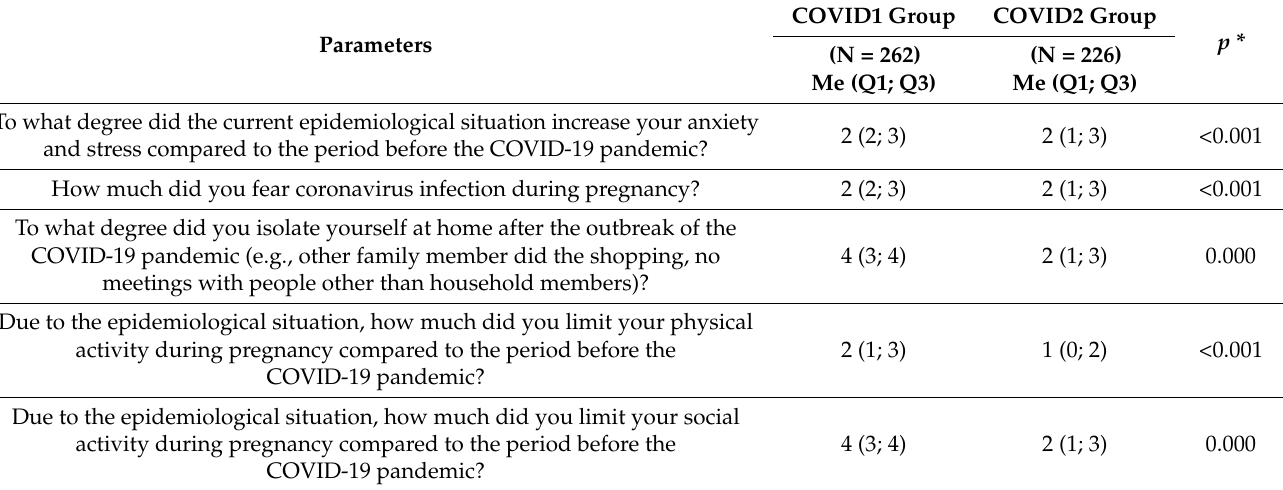
Table A4. The impact of the COVID-19 pandemic on changes in the lifestyle and psychophysical state of women giving birth during the pandemic.